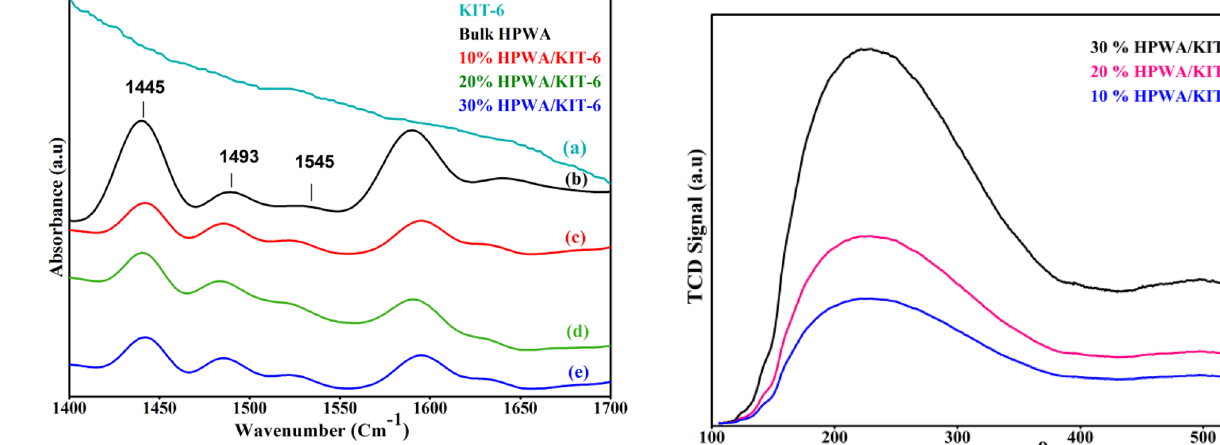
Figure 4 represented NH